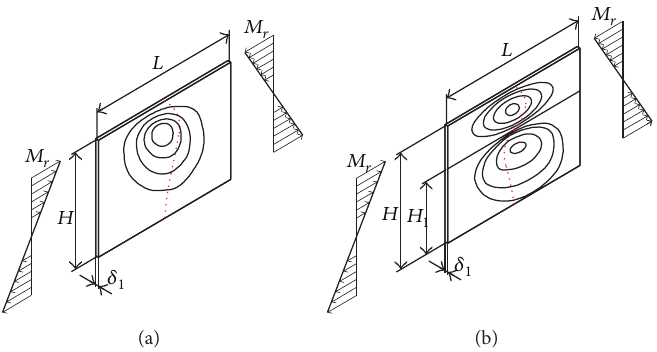
Figure 8: Buckling modes of the rib of the monocell (a) and two-cell (b) box